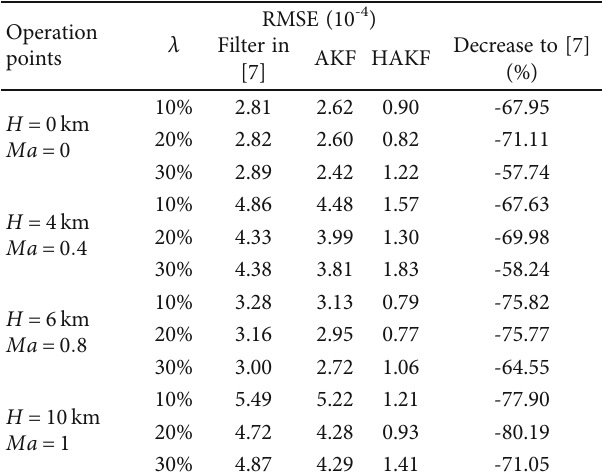
Table 1: n L RMSE of three methods.